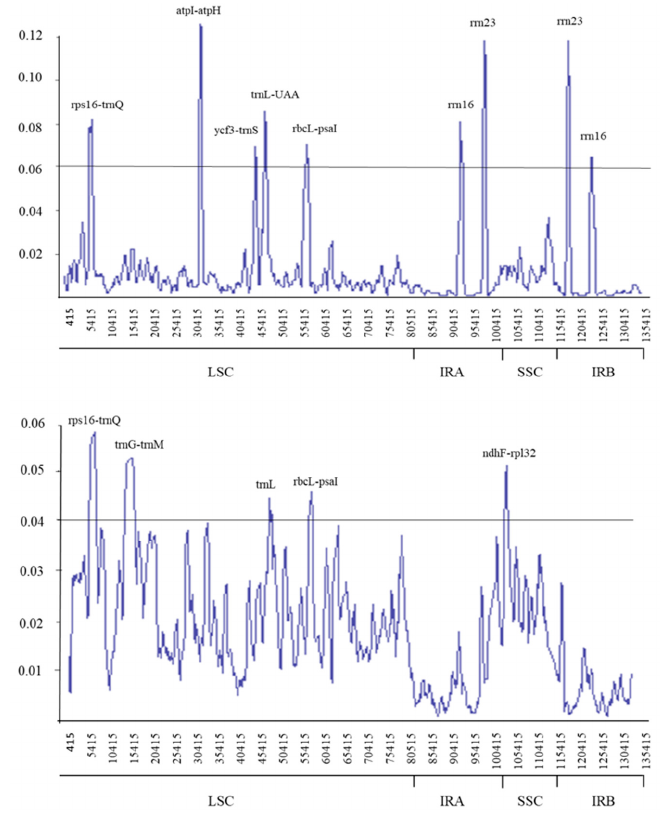
Figure 4. Sliding window analysis of the whole chloroplast genomes. ( A ) Pi among E. pilosa and E. tef . ( B ) Pi among E. pilosa and other eight species. Window length: 800 bp; step size: 200 bp. X-axis: position of the midpoint of a window. Y-axis: nucleotide diversity of each window.